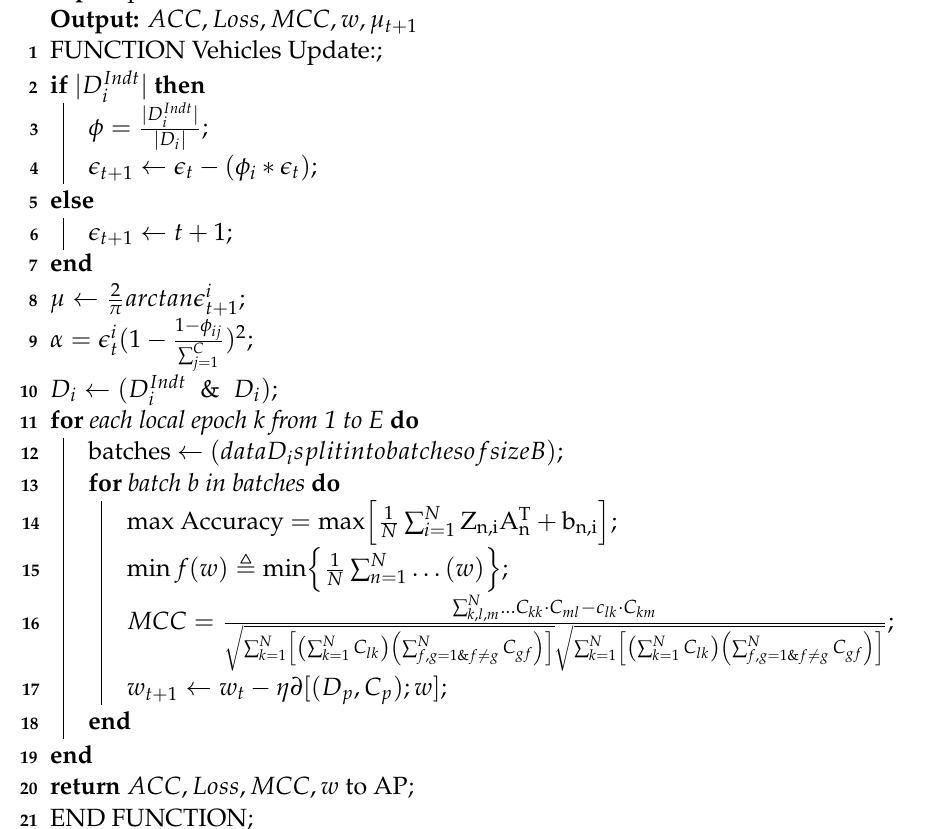
Algorithm 2 AP Node-vehicle diversity selection algorithm. It takes ω , t and (cid:101) t